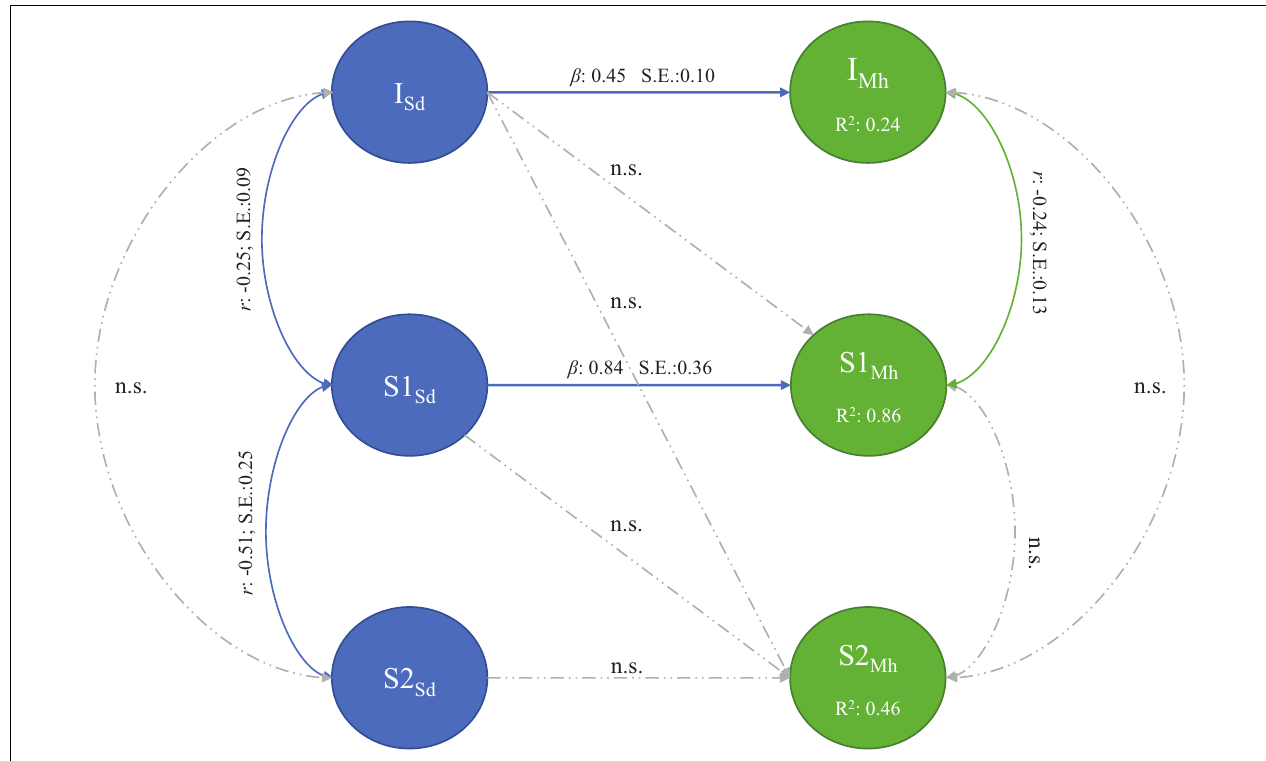
FIGURE 4 | Sequential piecewise multi-process latent growth model: study resources and mental health.